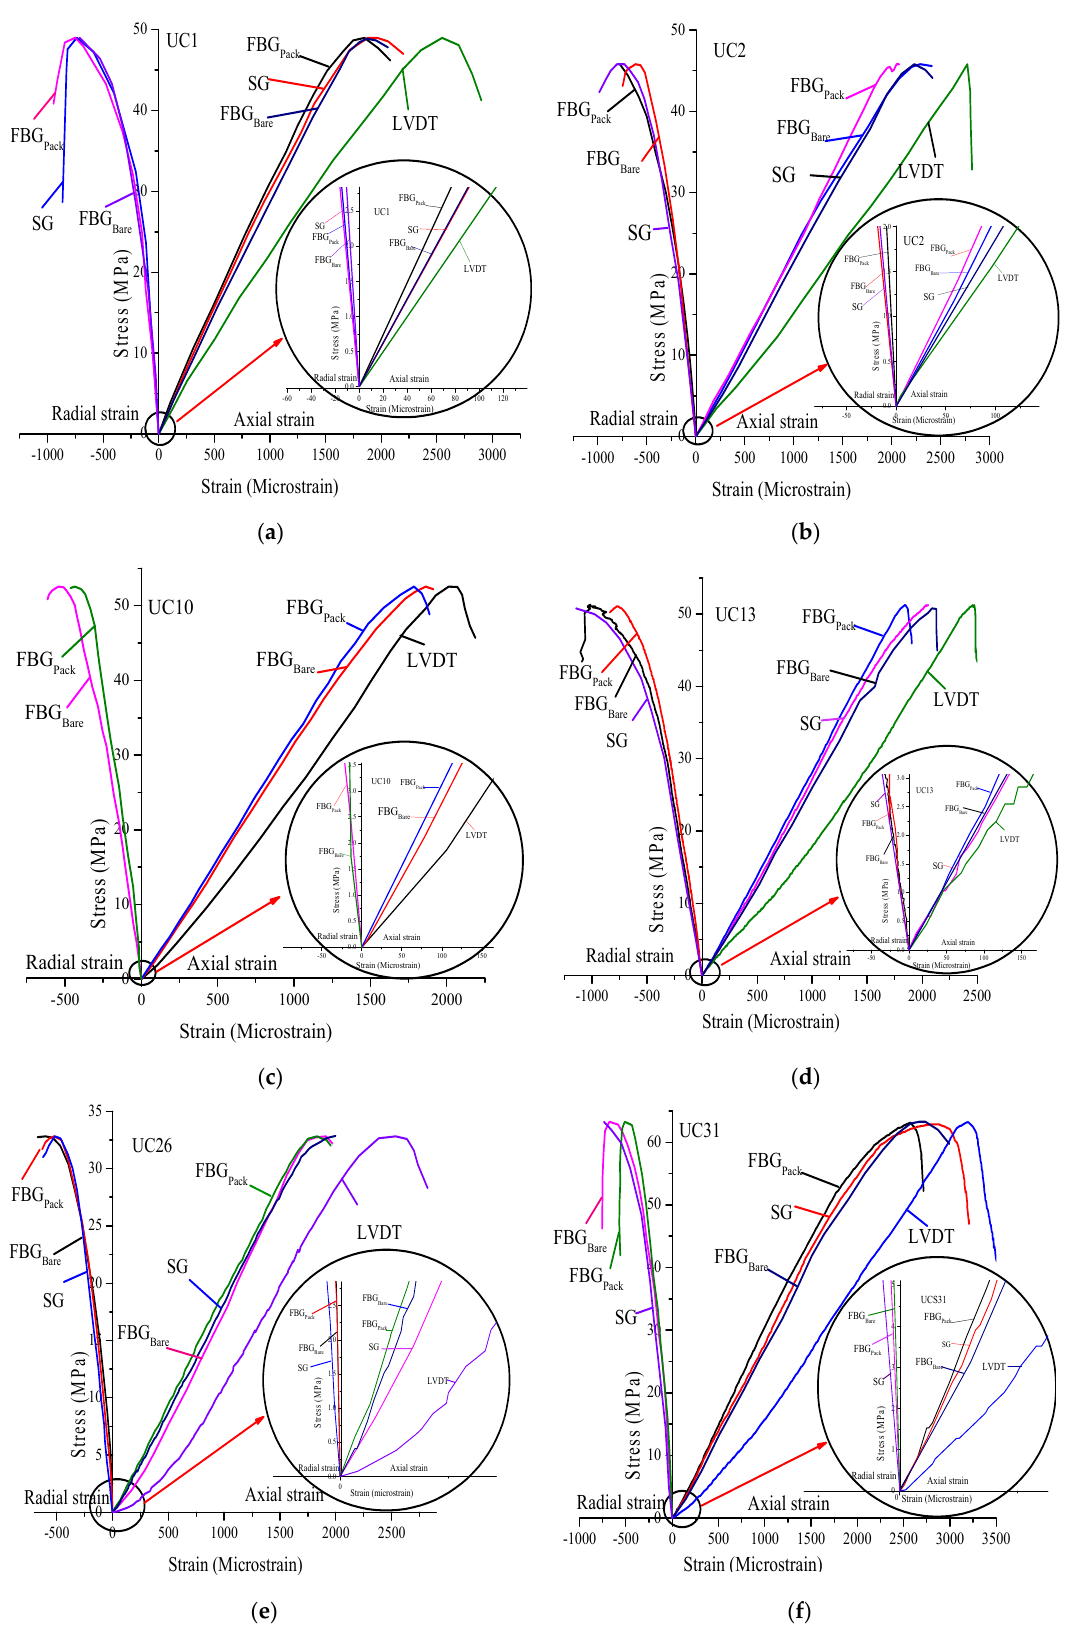
Figure 6. Experimental stress-strain curves of limestone specimens ( a ) UC1, ( b ) UC2, ( c ) UC10, ( d ) UC13, ( e) UC26, and ( f ) UC31.